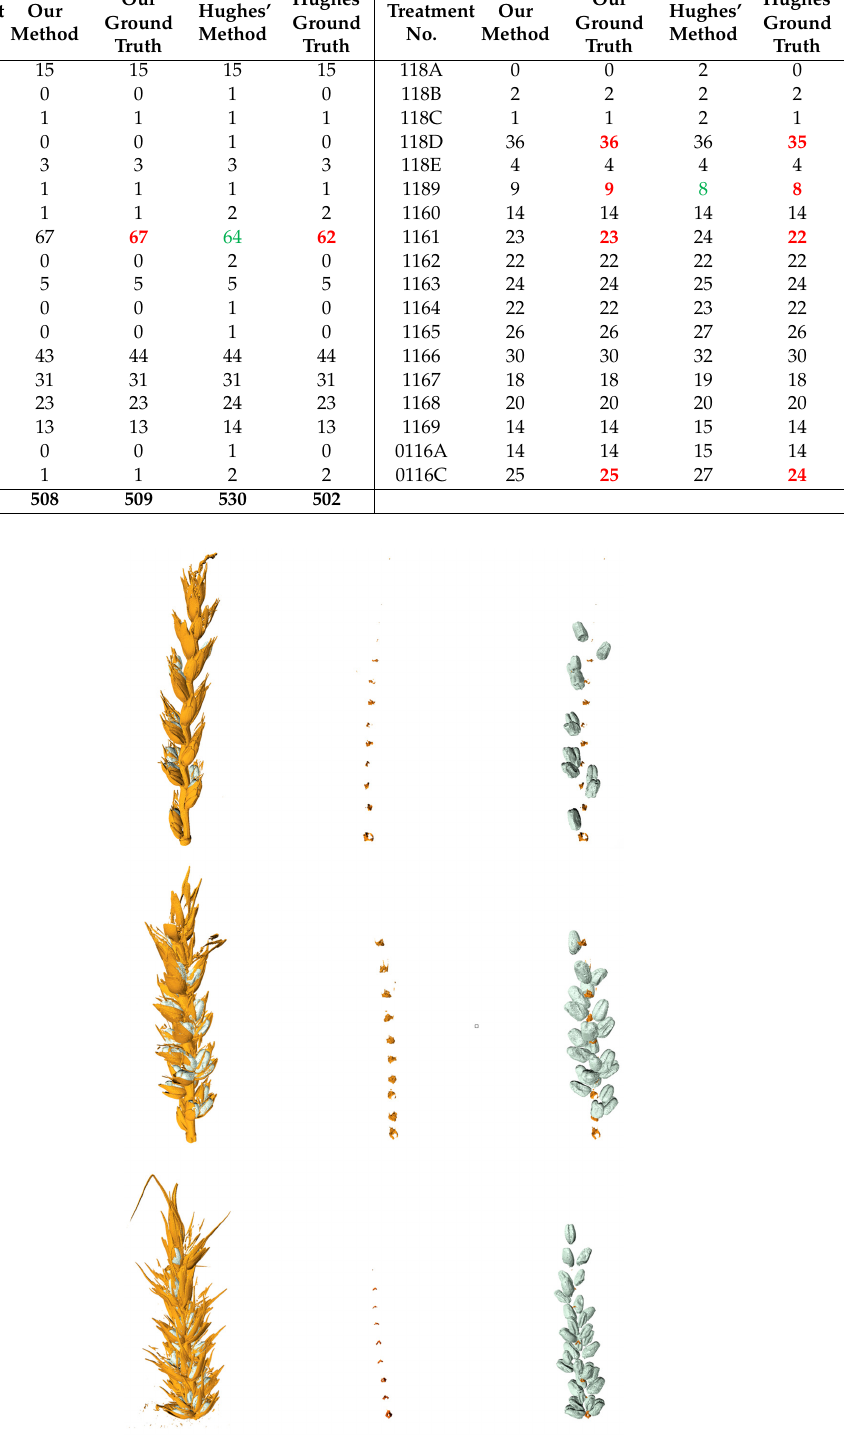
Figure 21. Detected stem nodes and grains. ( a ) The whole wheat spike; ( b ) the detected stem nodes; ( c ) the detected grain and stem node. Upper row is spike No. 1170, middle row is bottom part of spike No. 1165 and bottom row is top part of spike No. 1178.